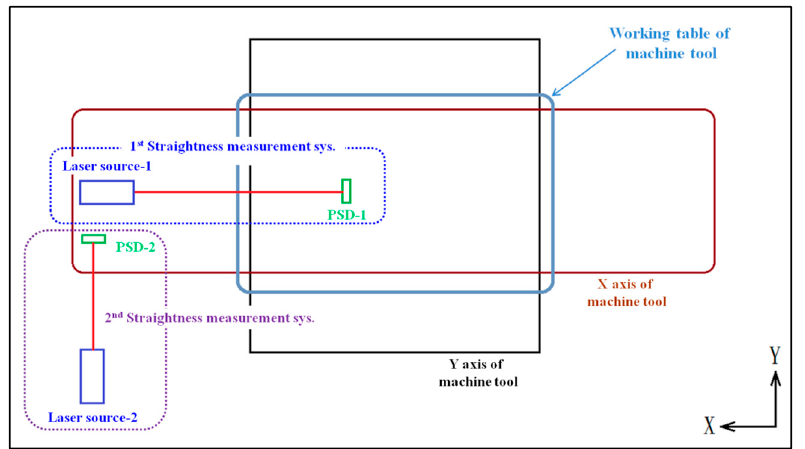
Figure 3. Schematic diagram of the dual-axis measurement system.